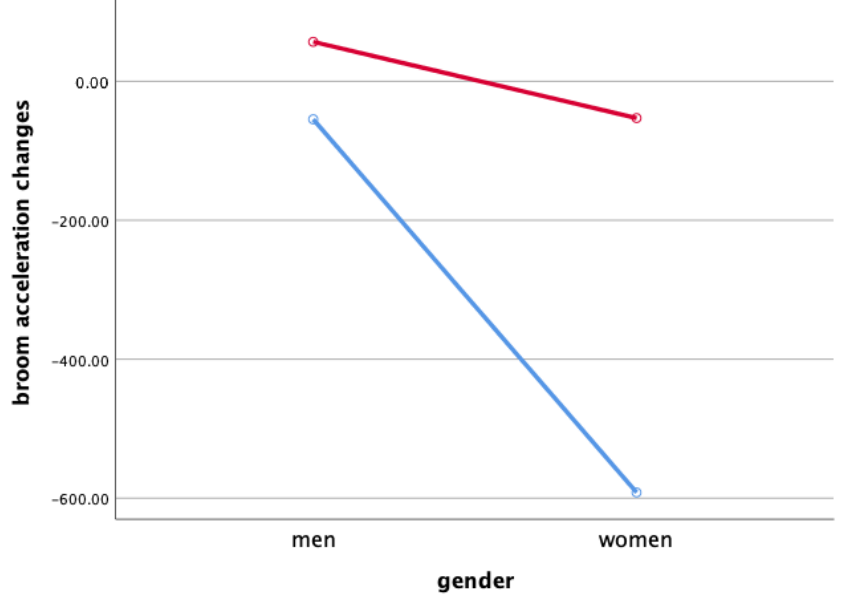
Figure 5. Broom Acceleration Changes When Sweeping(Z)—main effect (mG). Red line: along the axis of motion, blue line: perpendicular to the axis of motion.